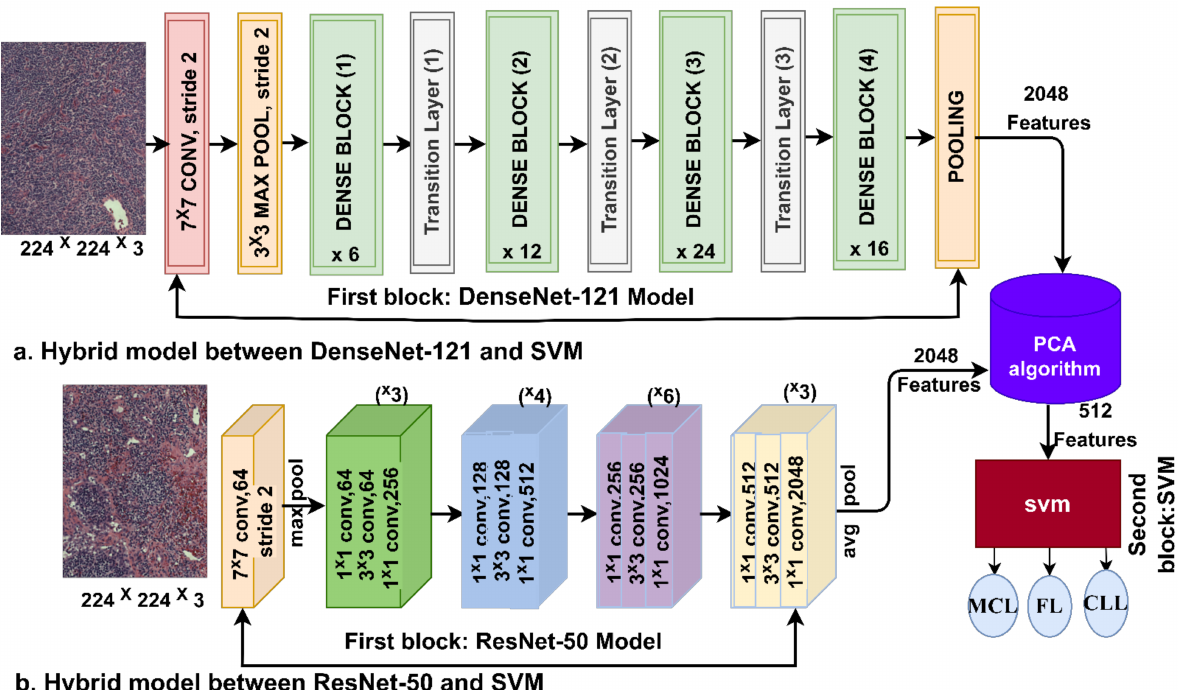
Figure 4. The infrastructure framework of the hybrid technique for the histological diagnosis of malignant